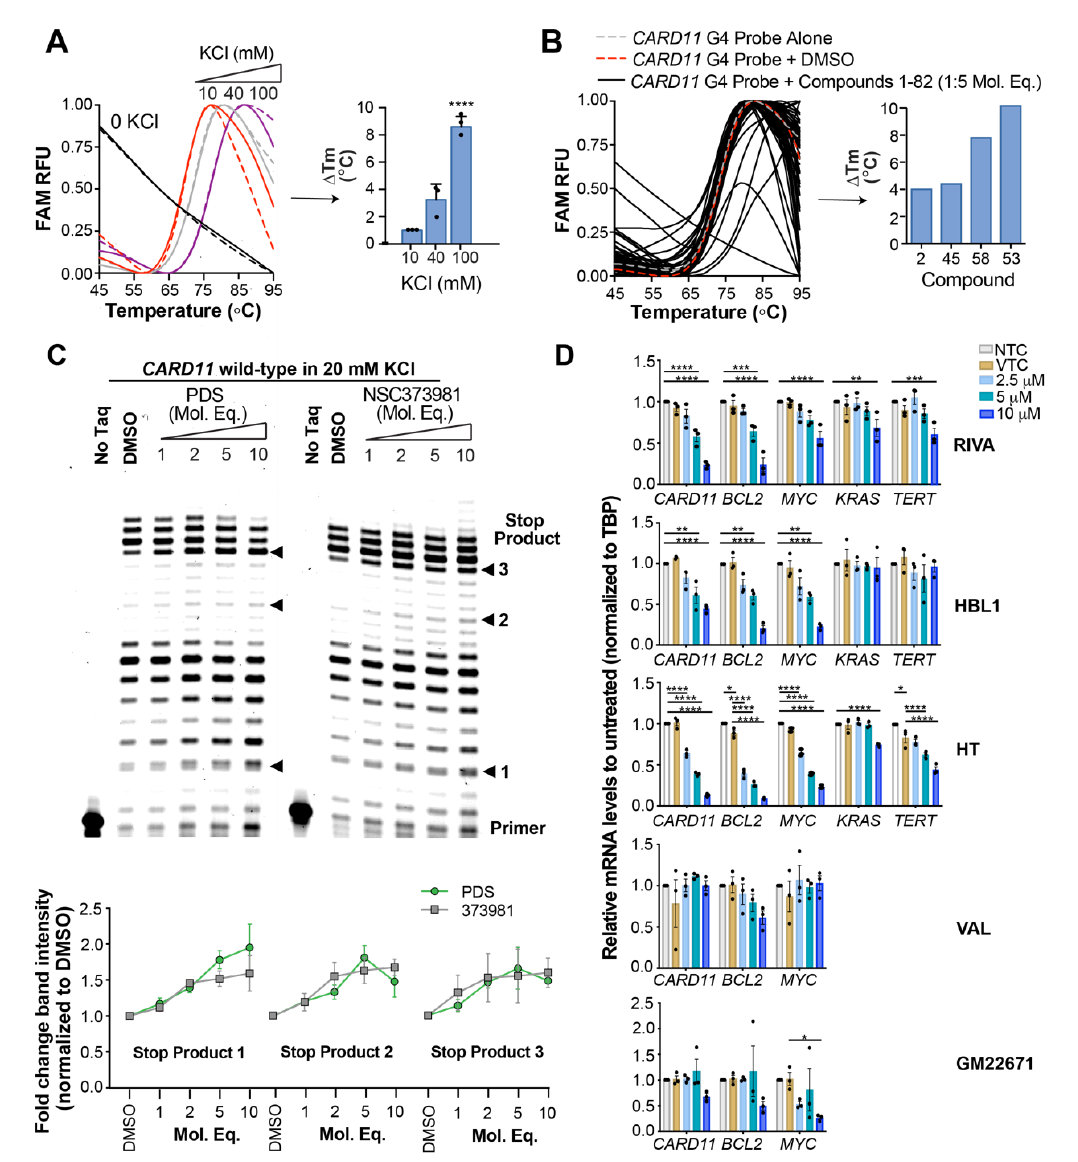
Figure 2. Identification of a CARD11 G-quadruplex (G4) stabilizing small molecule that